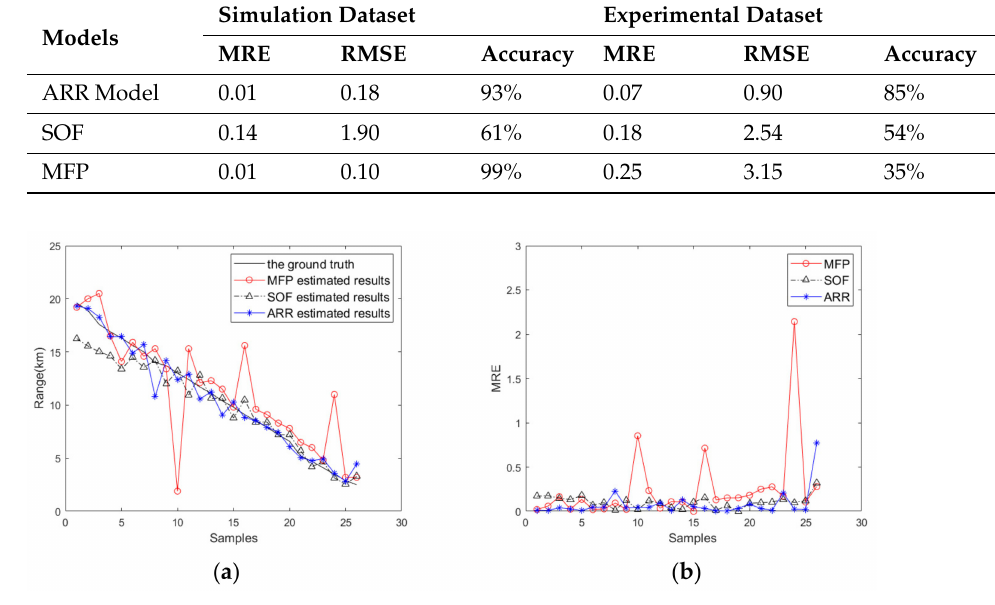
Figure 15. ( a ) Estimated results and ( b ) MRE of MFP, SOF and ARR on the test